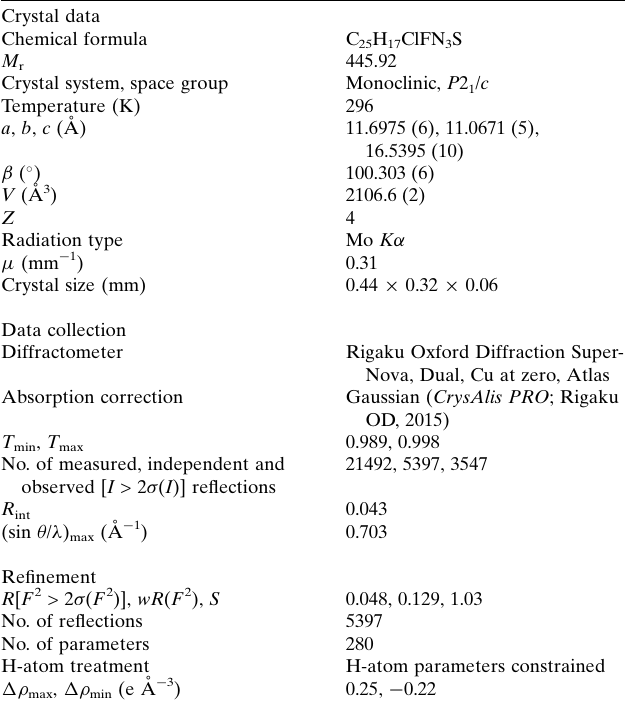
Table 2 Experimental details. Crystal data Chemical formula